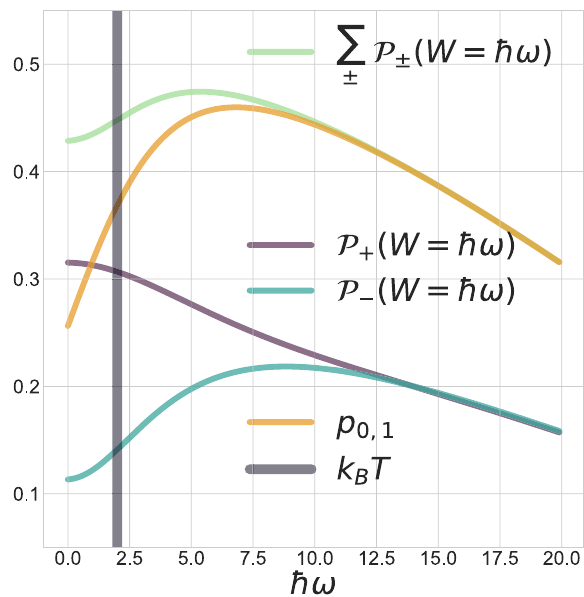
Fig. 5 Work probabilities of a spin-1/2 system under the time-dependent Hamiltonian with varying the work invested ℏ ω . For values of ℏ ω smaller or of the order of β − 1 = k B T = 1/2 ( k B = ℏ = 1), the work probabilities P W ¼ _ ω Þ and P W ¼ _ ω Þ (see Eq. (31); turquoise and purple curves) þ ð (cid:2) ð strongly depend on the interference terms. For values ℏ ω ≫ β − 1 , P W ¼ _ ω Þþ P W ¼ _ ω Þ (green curve) tends to the value p þ ð (cid:2) ð curve), which is obtained by projecting the process to the forward direction and obtaining the work difference ℏ ω . This illustrates that observing large work values ℏ ω ≫ β − 1 ( ℏ ω ≪ − β − 1 ) effectively projects the process onto the forward (time-reversal)